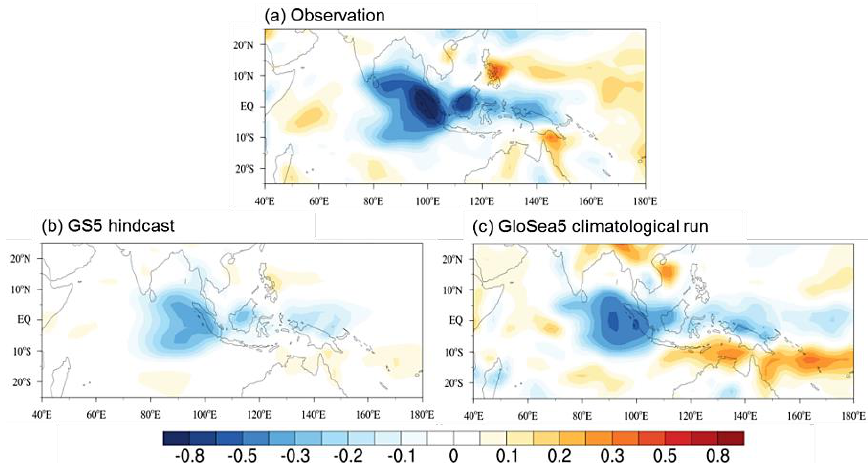
Figure 6. The regressed 20–70-day filtered 925 hPa boundary layer moisture convergence (day −1 ) onto filtered precipitation (20–70 days) averaged over the eastern Indian Ocean (10° S–10° N, 80°–100° E) from ( a ) observation, ( b ) GS5 hindcast data, and ( c ) GS5 climatological run. The strengths of regression are fixed to a 3 mm day −1 .